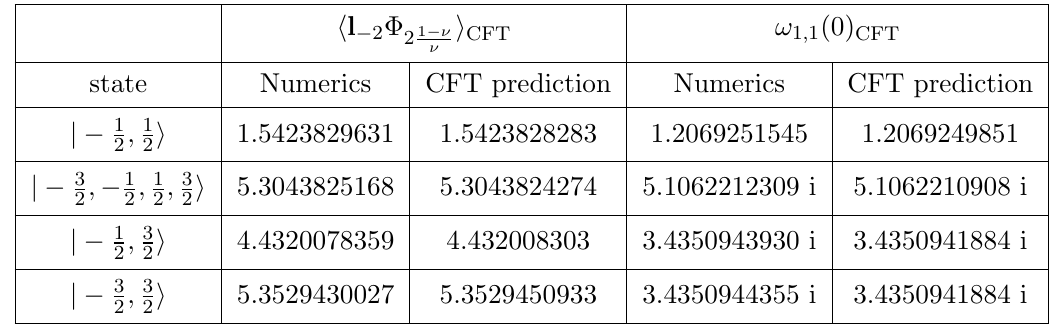
Table 2 . Numerical data for the expectation values of the level 2 descendant (cid:12)elds; l (cid:0) 2 (cid:8) (cid:0) (cid:1) and l (cid:0) 2 1, at the (cid:23) = 4 ; ‘ = 10 (cid:0) 2 point of the parameter space. 7